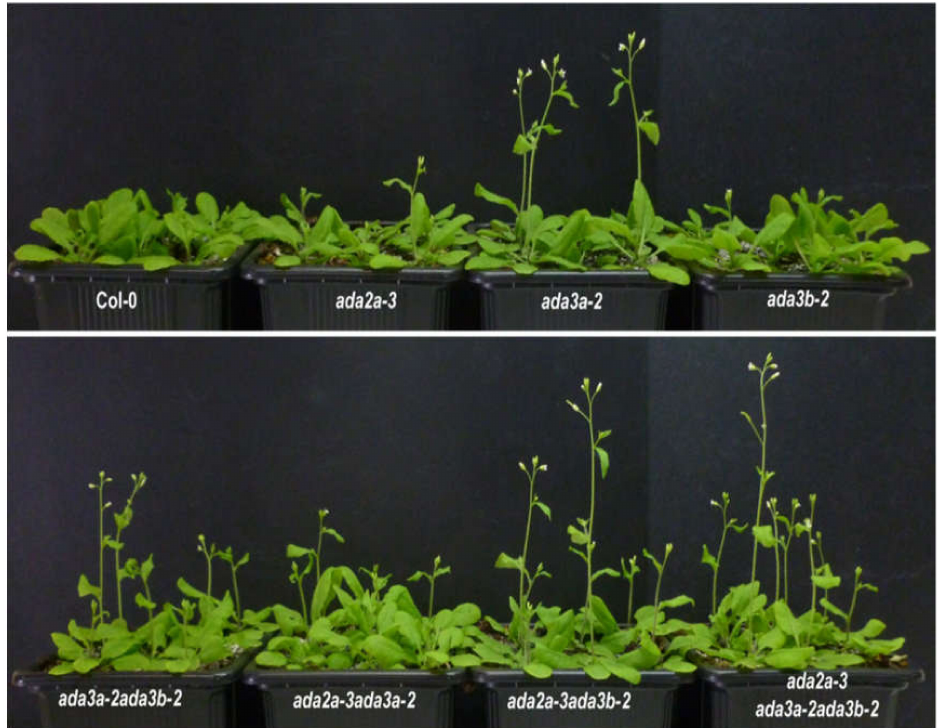
Figure 5. The effect of ADA2a, ADA3a, and ADA3b on flowering. Four-week-old Col-0, ada2a-3 , ada3a-2 , ada3b-2 , ada3a-2ada3b-2 , ada2a-3ada3a-2 , ada2a-3ada3b-2, and ada2a-3ada3a-2ada3b-2 mutant plants grown under long-day